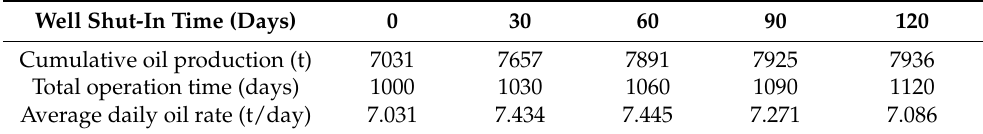
Table 5. Average production rates for different simulation cases.